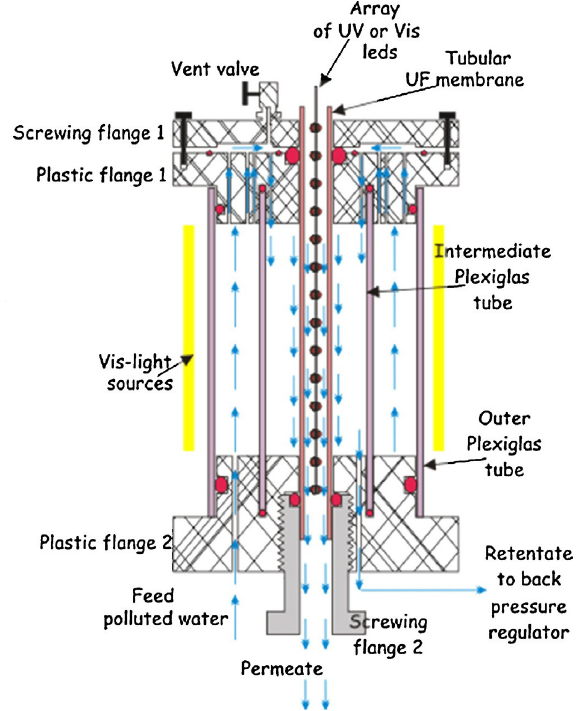
Figure 20. Illustration of a membrane reactor with photocatalytic support for combined visible light photocatalysis and ultrafiltration. (Reprinted/adapted with permission from Ref. [98]).